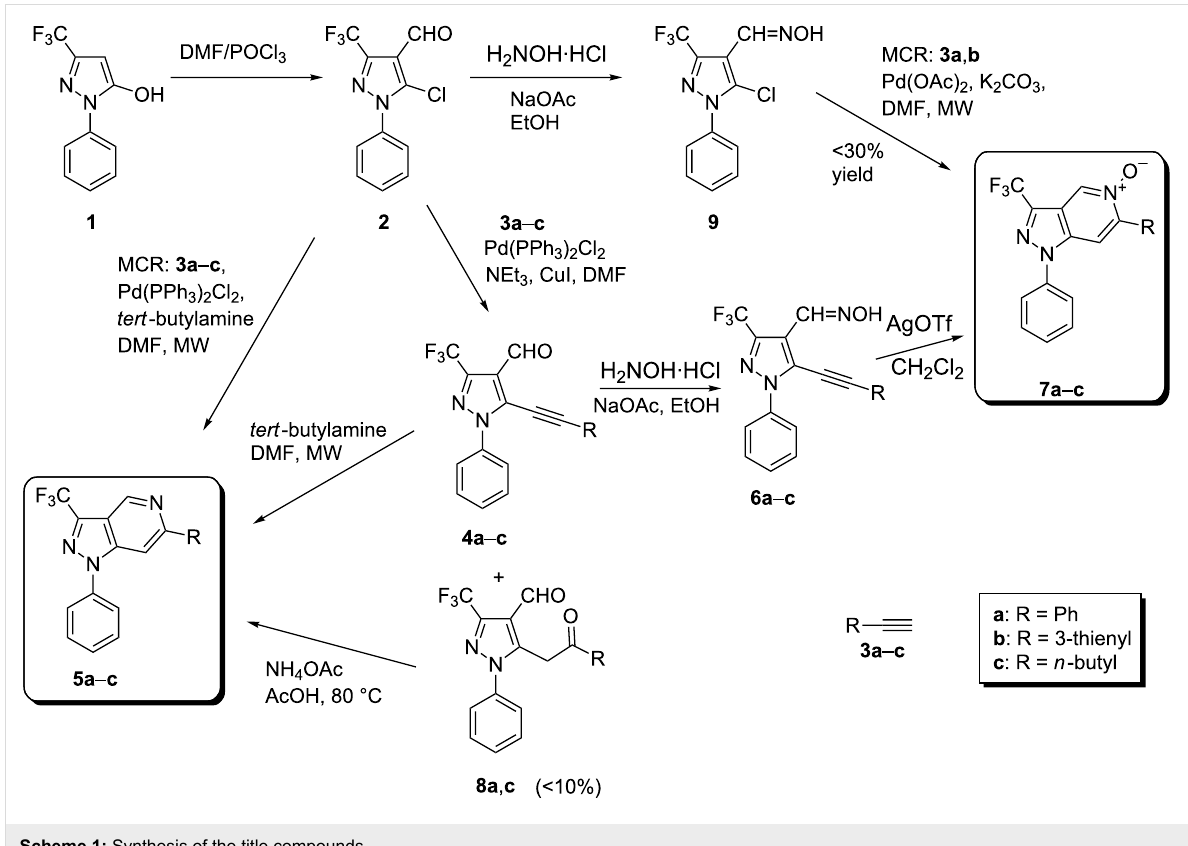
Scheme 1: Synthesis of the title